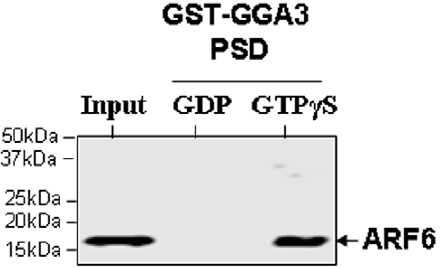
Figure 4. GST-GGA3 PBD binding to ARF6-GTP. Myometrium tissue isolated from non-pregnant woman was lysed and the lysate was incubated with 0.1 mM GTP c S or 1 mM GDP for 30 min. The glutathione resin coupled to GST-GGA3 PBD was added to the lysate and continued the incubation for further 2 h. After washing the beads, the protein bound to the beads were analysed by immunoblotting using an anti-ARF6 mouse monoclonal antibody. The lysates that were not incubated with beads were used as input controls in immunoblot- ting.